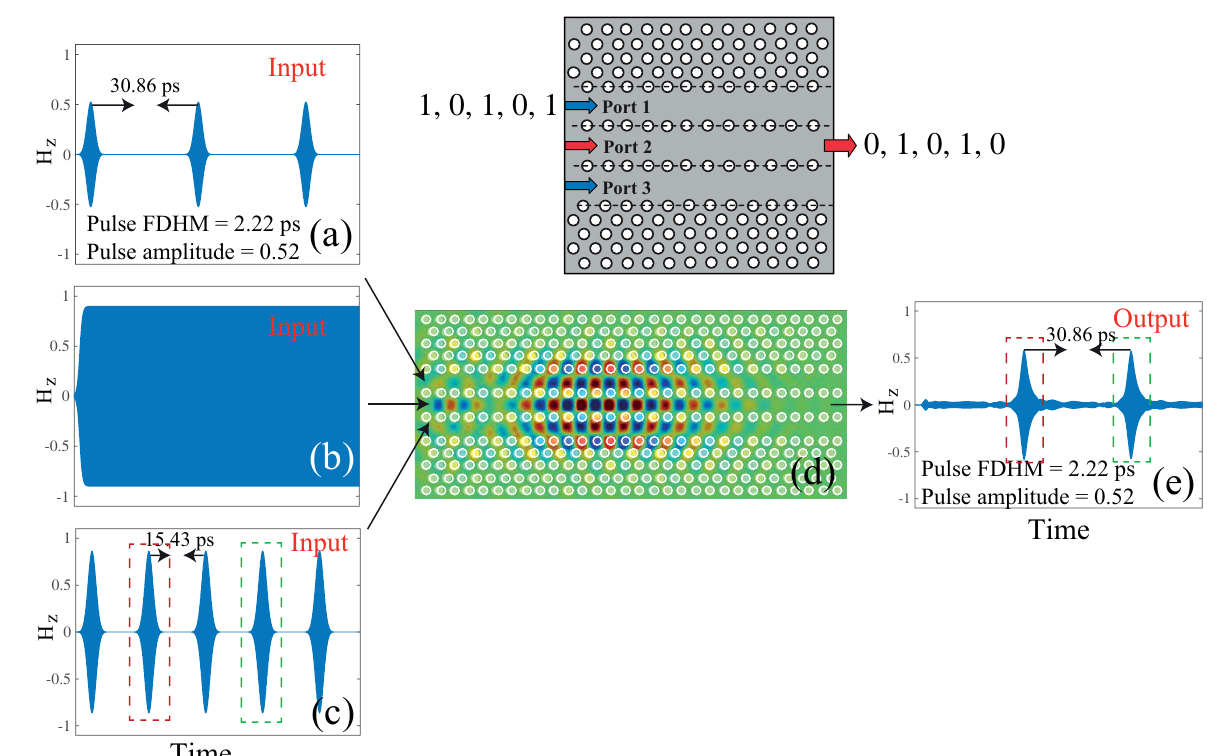
Figure 5. All-optical NOT logic gate: ( a – c ) display the pulses injected into the Ports: three Gaussian pulses with pulse repetition time of ( 2 · 15.43 ) = 30.86 ps, FDHM of 2.22 ps and amplitude A = 0.52 are injected into Port 1; a CW signal with amplitude A = 0.956 is injected into Port 2; a train of five Gaussian pulses with pulse repetition time of 15.43 ps, the FDHM of 2.22 ps and amplitude A = 0.812 is injected into Port 3. Graph ( d ) shows the magnetic field profile of the propagating signal pulse and graph ( e ) displays the magnetic field H z of the output